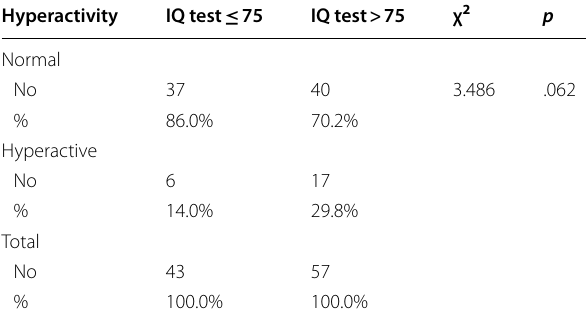
Table 4 The relation between hyperactivity and IQ